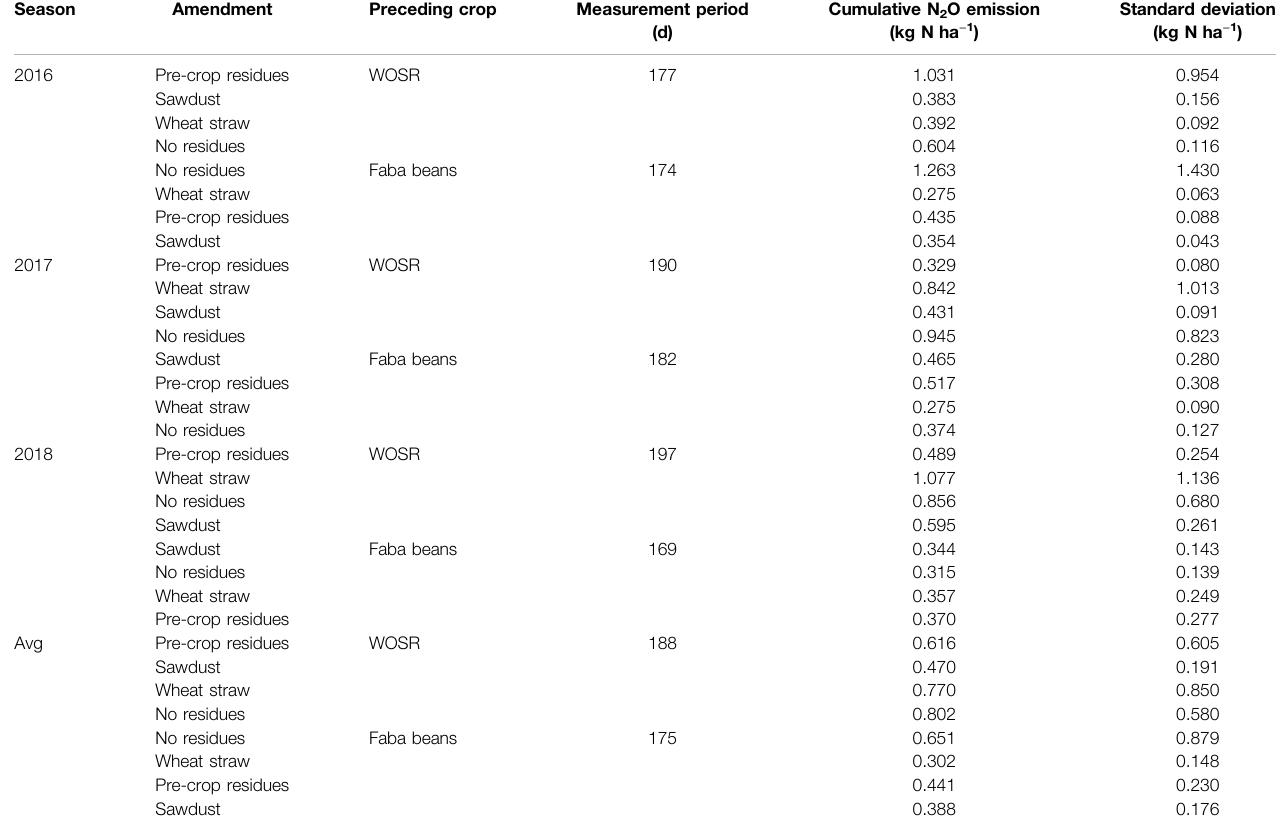
TABLE 2 | Cumulative N 2 O emissions per treatment and season; n (cid:2) 4, respectively, 8 for 2017/18. Season Amendment